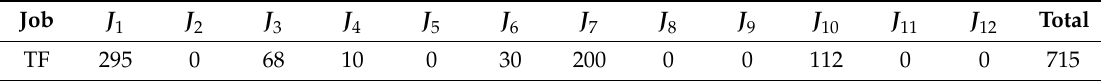
Table 6. The TF of the jobs in the given schedule.